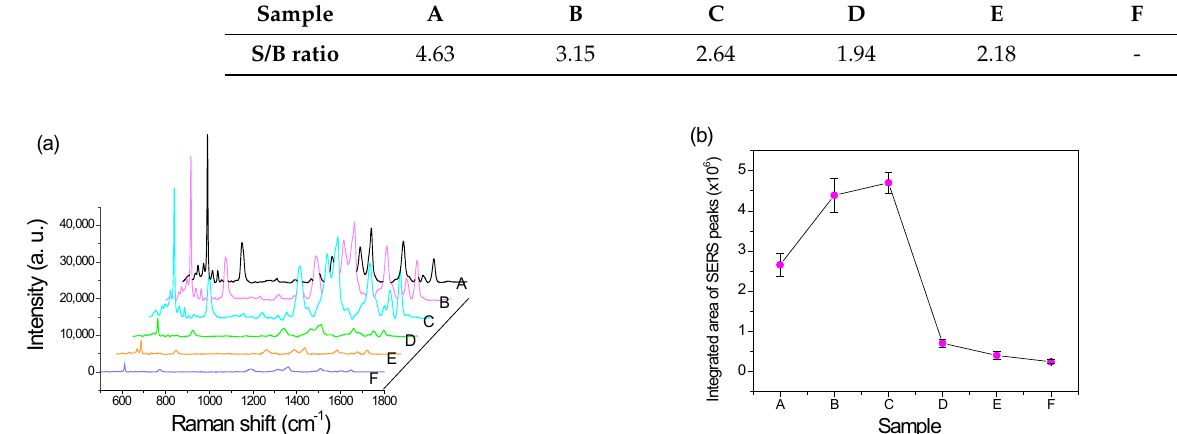
Figure 8. ( a ) The background-subtracted SERS spectra and ( b ) their integrated intensities of the 10 −6 M R6G analyte on different thicknesses of the Ag-deposited substrate.